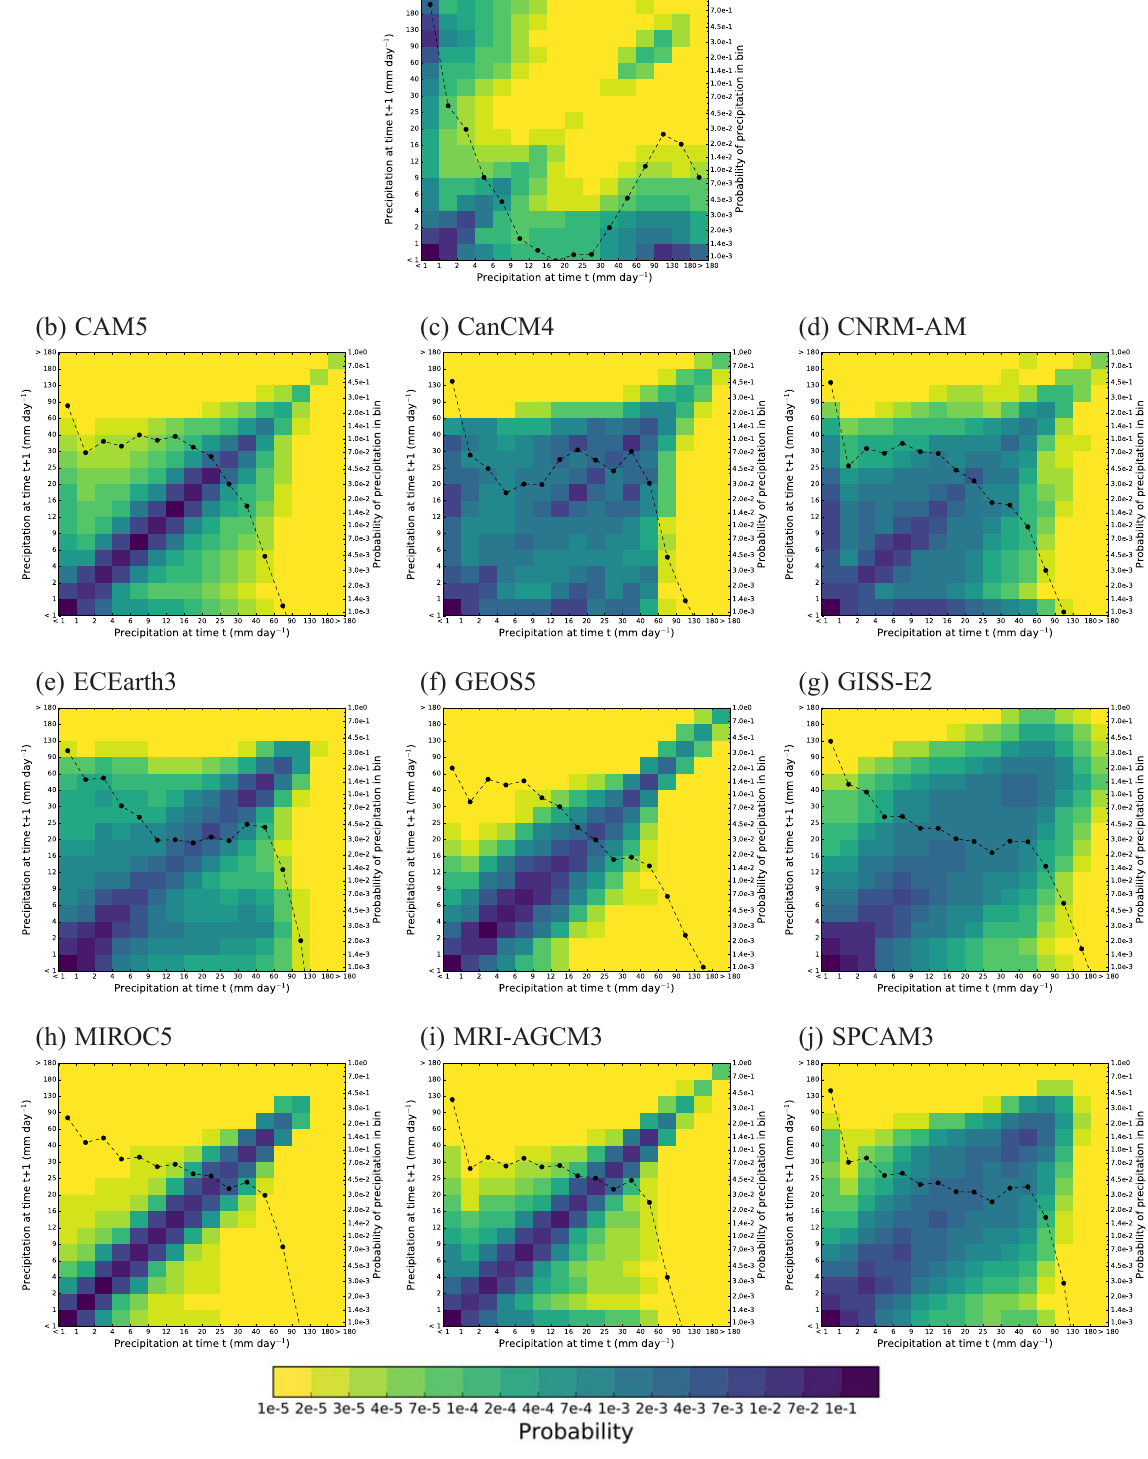
Figure 4. For each model in the GASS/YoTC dataset and using time step precipitation data on the native model grid: filled blocks show the normalized 2-D histogram of binned values on consecutive time steps, aggregated over all gridpoints; the dashed black line shows the normalized 1-D histogram, using the right-hand axis. Note the logarithmic color scale. See Table 1 for information on time step length and grid